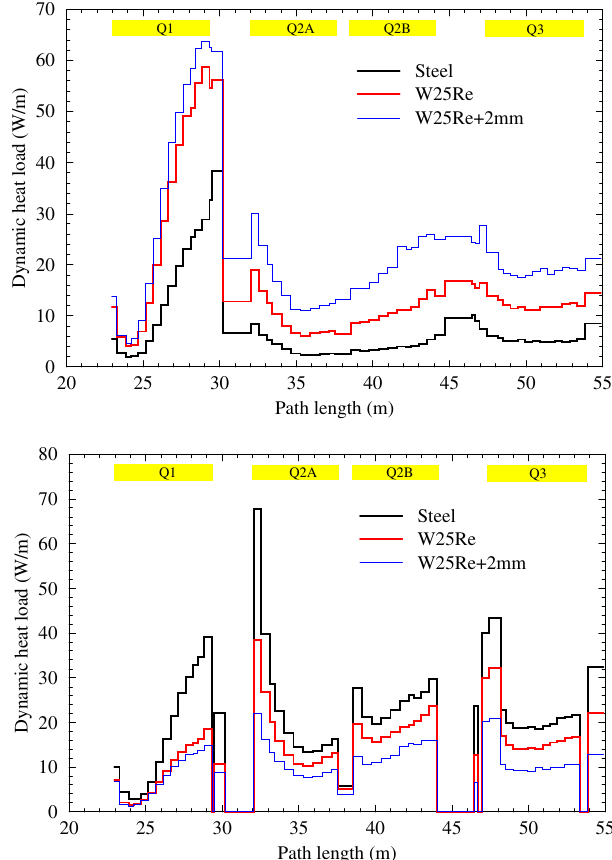
FIG. 11. (Color) Dynamic heat load to the liner (top) and super- conducting coils (bottom) of the 100-mm Nb and correctors calculated for the steel and W25 Re liners of baseline thickness as well as for a W25 Re liner of increased thickness. W25 Re is used to replace both the steel liner and 1.5- mm steel cold bore adjacent to the liner (see Fig. 2).